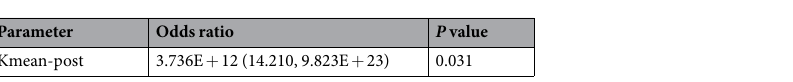
Table 2. Significant parameters in the multivariate logistic regression models. Data are odds ratios and P - values. Data in parentheses are 95% confidence